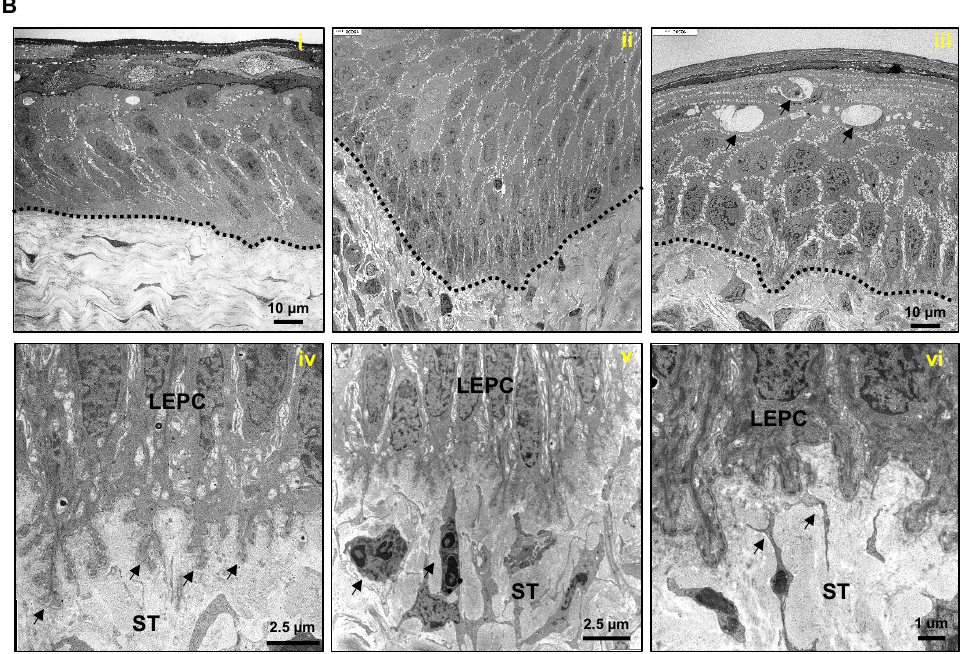
Figure 1. Histology of porcine ocular surface: ( A ) Light micrographs of paraffin sections of corneoconjunctival tissue stained with hematoxylin and eosin (HE) showing the corneal epithelium consists of 6 – 8 layers of stratified epithelium and Bowman’s layer is not evident; deep invaginations of the limbal epithelium (6 – 12 layers) analogous to the limbal interpalisade crypts of human limbal tissue can be observed in the limbal zone; the bulbar conjunctiva is composed of a 3 – 5 layered stratified epithelium; significant vessels (arrows) in the limbal and conjunctival stroma. The conjunctival and limbal stroma are organized differently to the corneal stroma, with loose connective tissue, a large number of fibroblasts, and the significant presence of vessels (arrows). Alcian blue (AB) staining of ocular surface showing the presence of glycosaminoglycans (blue) throughout the cornea and rather weak staining in the limbal and conjunctival stroma and the presence of goblet cells in the conjunctival epithelium (arrows). Periodic acid - Schiff (PAS) staining highlighting the BM of porcine corneal epithelium (arrows) and less pronounced in the epithelial BM of limbus and conjunctiva. ( B ) Transmission electron micrographs showing the architecture of the corneal ( i ), limbal ( ii ), and the presence of goblet cells in the conjunctival epithelia (arrows, ( iii )) (dotted line represents basement membrane); extensive basal cell processes of limbal epithelial progenitor cells (LEPC) extending into the limbal stroma (ST) (arrows, ( iv )), close interactions with stromal immune cells (arrows, ( v )) and with mesenchymal stromal cells (arrows, ( vi